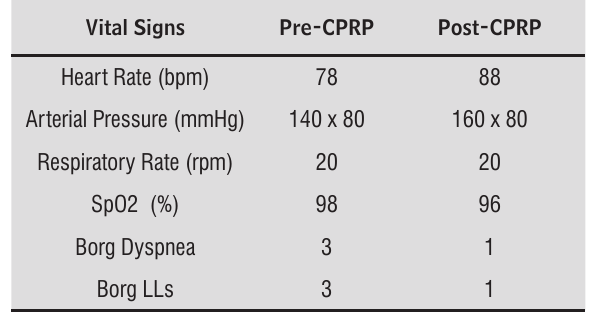
Figure 2 - Walk distance in the 6MWT pre and post CPRP.